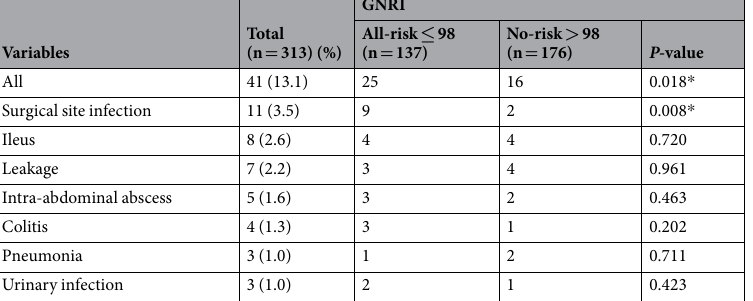
Degree of differentiation (por, pap, muc/tub1, tub2) 1.292